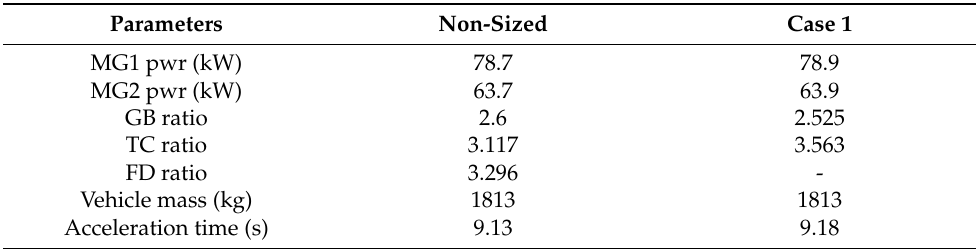
Figure 4. Results on entire range versus TC and GB and feasible points: ( a ) acceleration results; and ( b ) fuel consumption results. Table 3. Component-sizing results and acceleration performance for Case